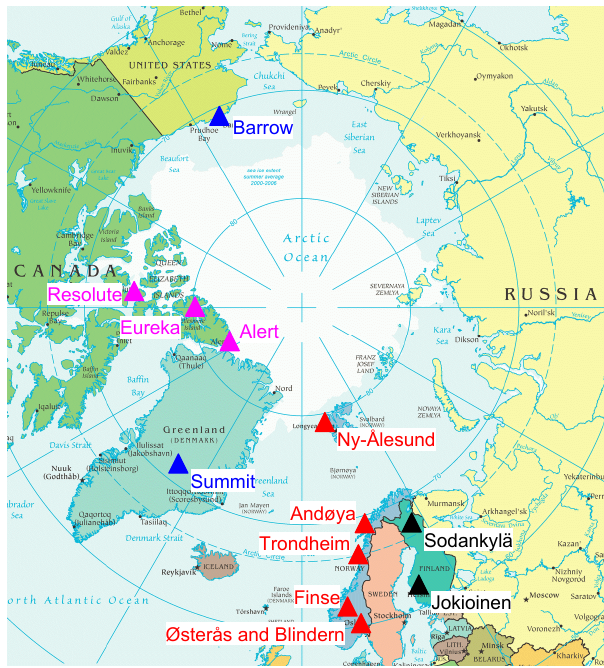
Fig. 1. Locations of instruments operated by Environment Canada (pink), Biospherical Instruments Inc. (blue), the Norwegian Radi- ation Protection Authority and the Norwegian Institute of Air Re- search (red), and the Finnish Meteorological Institute